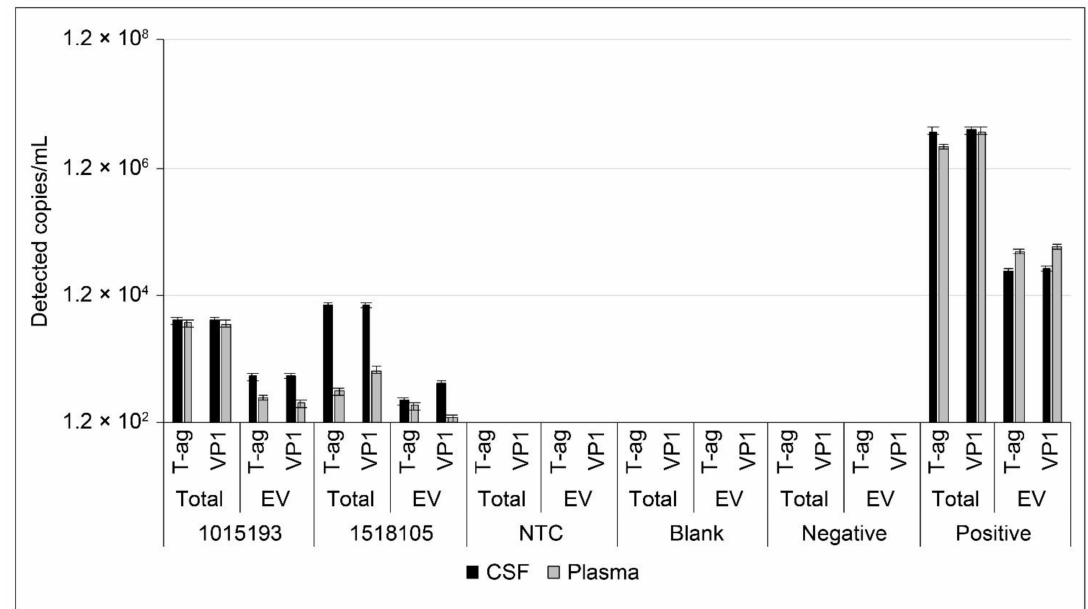
Figure 9. Individual ddPCR results for detection of JCPyV in CSF- and plasma-derived EV from patients with diagnosed PML. EV were isolated using size-exclusion chromatography mini columns followed by ultrafiltration using Amicon Ultra-4 columns. Purified and concentrated EV were processed according to the workflow diagram and analyzed by ddPCR for JCPyV genomes. Total samples were DNA extracted, digested, and similarly analyzed. The y-axis represents 120 copies/mL and is the equivalent of two positive drops at the correct amplitude. All of these samples are considered JCPyV positive. PML = progressive multifocal leukoencephalopathy. Error bars represent the standard